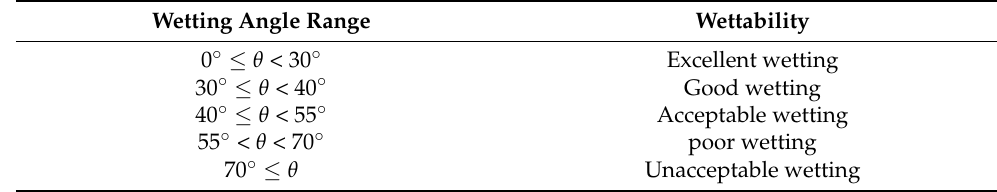
Table 3. The correlation of wetting angle range with wettability.